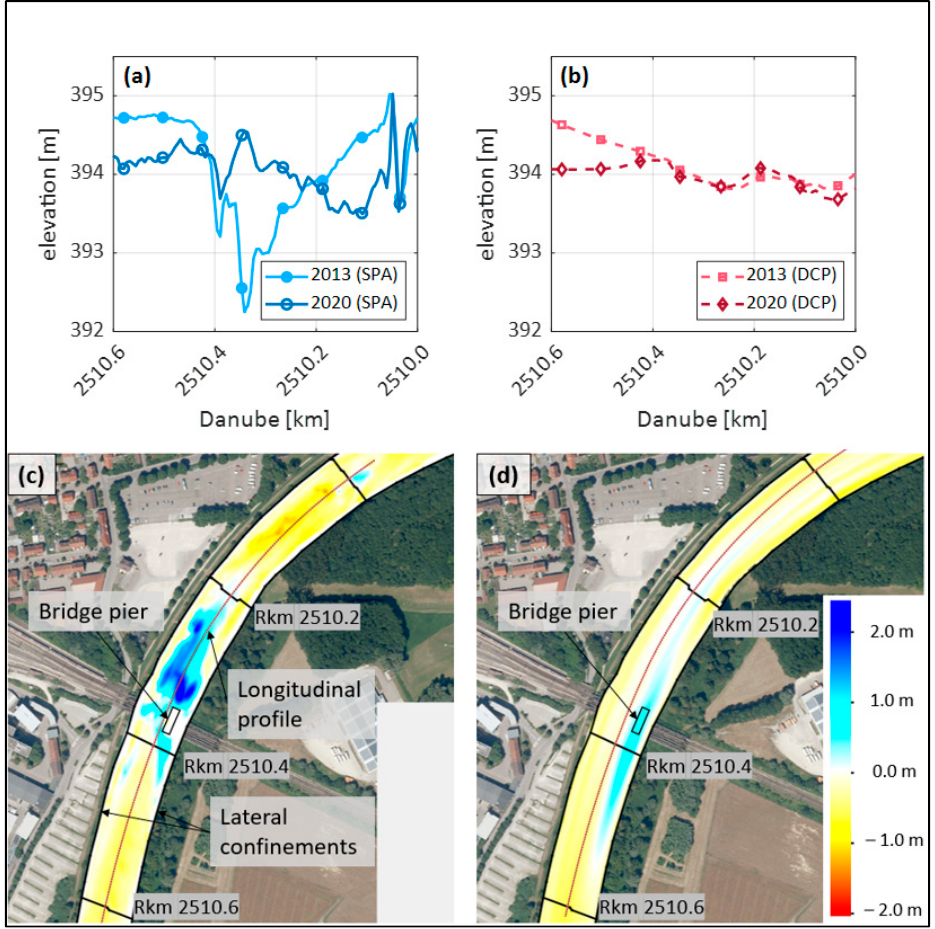
Figure 8. Longitudinal profiles for 2013 and 2020 for SPA ( a ) and DCP data ( b ), and the corresponding elevation difference from 2013 to 2020 for SPA ( c ) and DCP data ( d ).